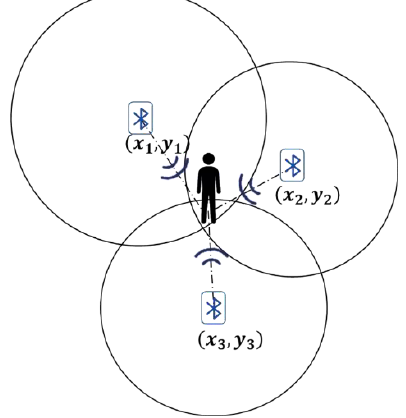
Figure 2. The diagram of trilateration